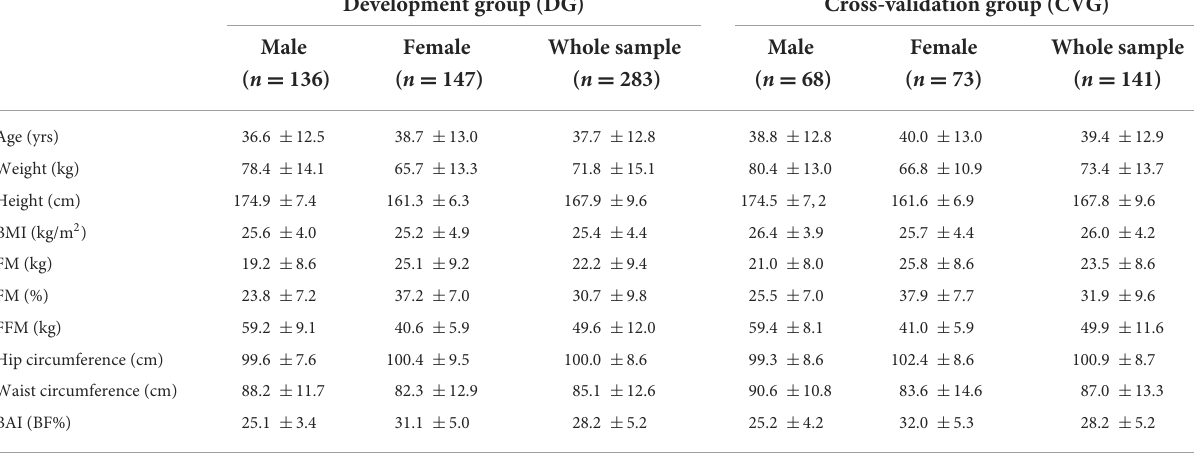
TABLE 1 Descriptive characteristics and body composition of development and cross-validation groups (mean ± sd).